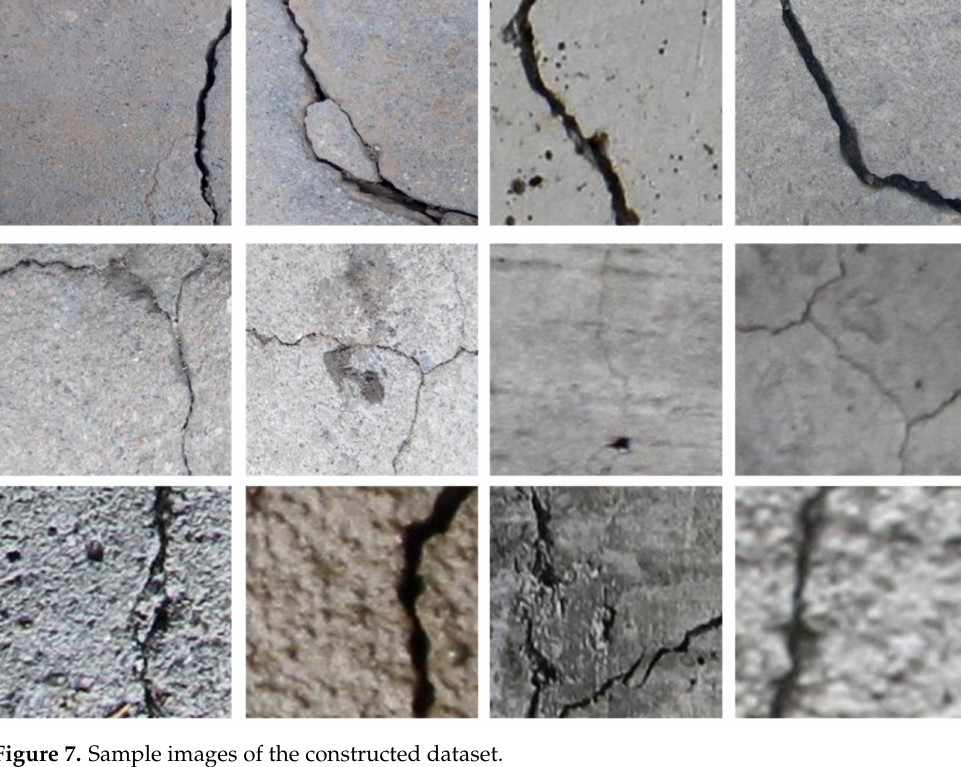
Figure 7. Sample images of the constructed dataset.